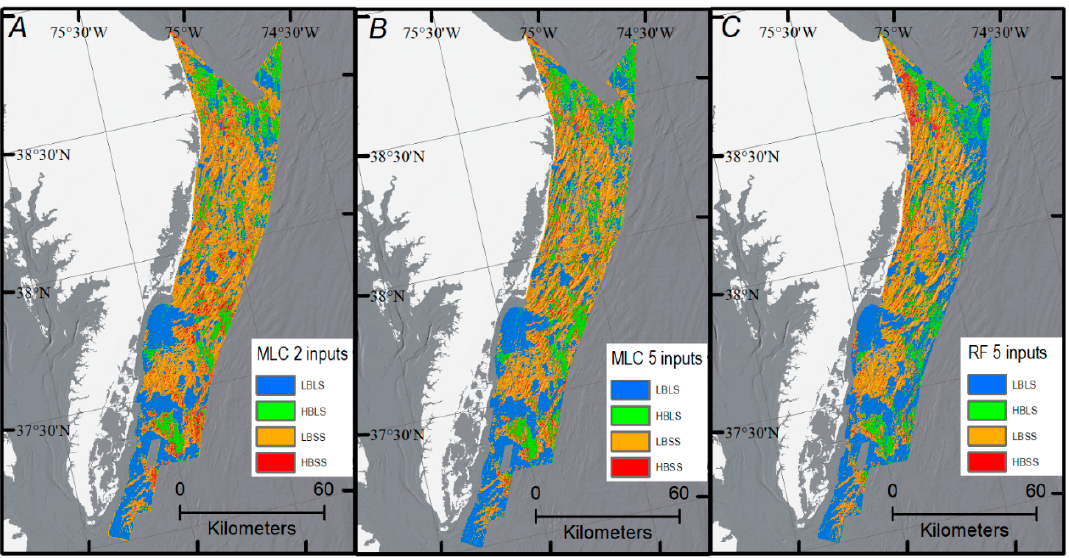
Figure 7. ( A ) MLC with two inputs, slope, and ISO-classified backscatter for the whole survey area. ( B ) MLC with five inputs, slope, ISO-classified backscatter, bathymetry, hillshaded-relief, and curvature. ( C ) RF with five inputs, slope, ISO-classified backscatter, bathymetry, relief, and curvature.